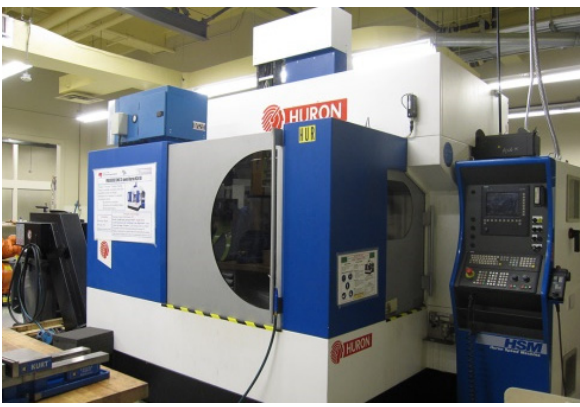
Figure 7. HURON K2X10 CNC milling machine.